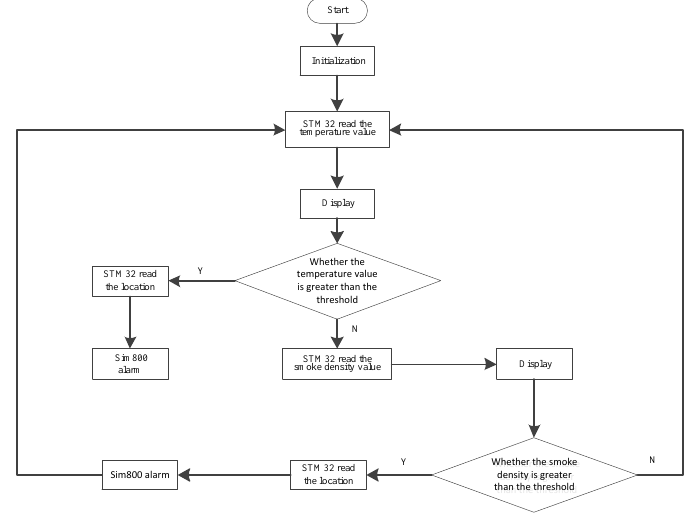
Fig. 8 . The software flow chart of the